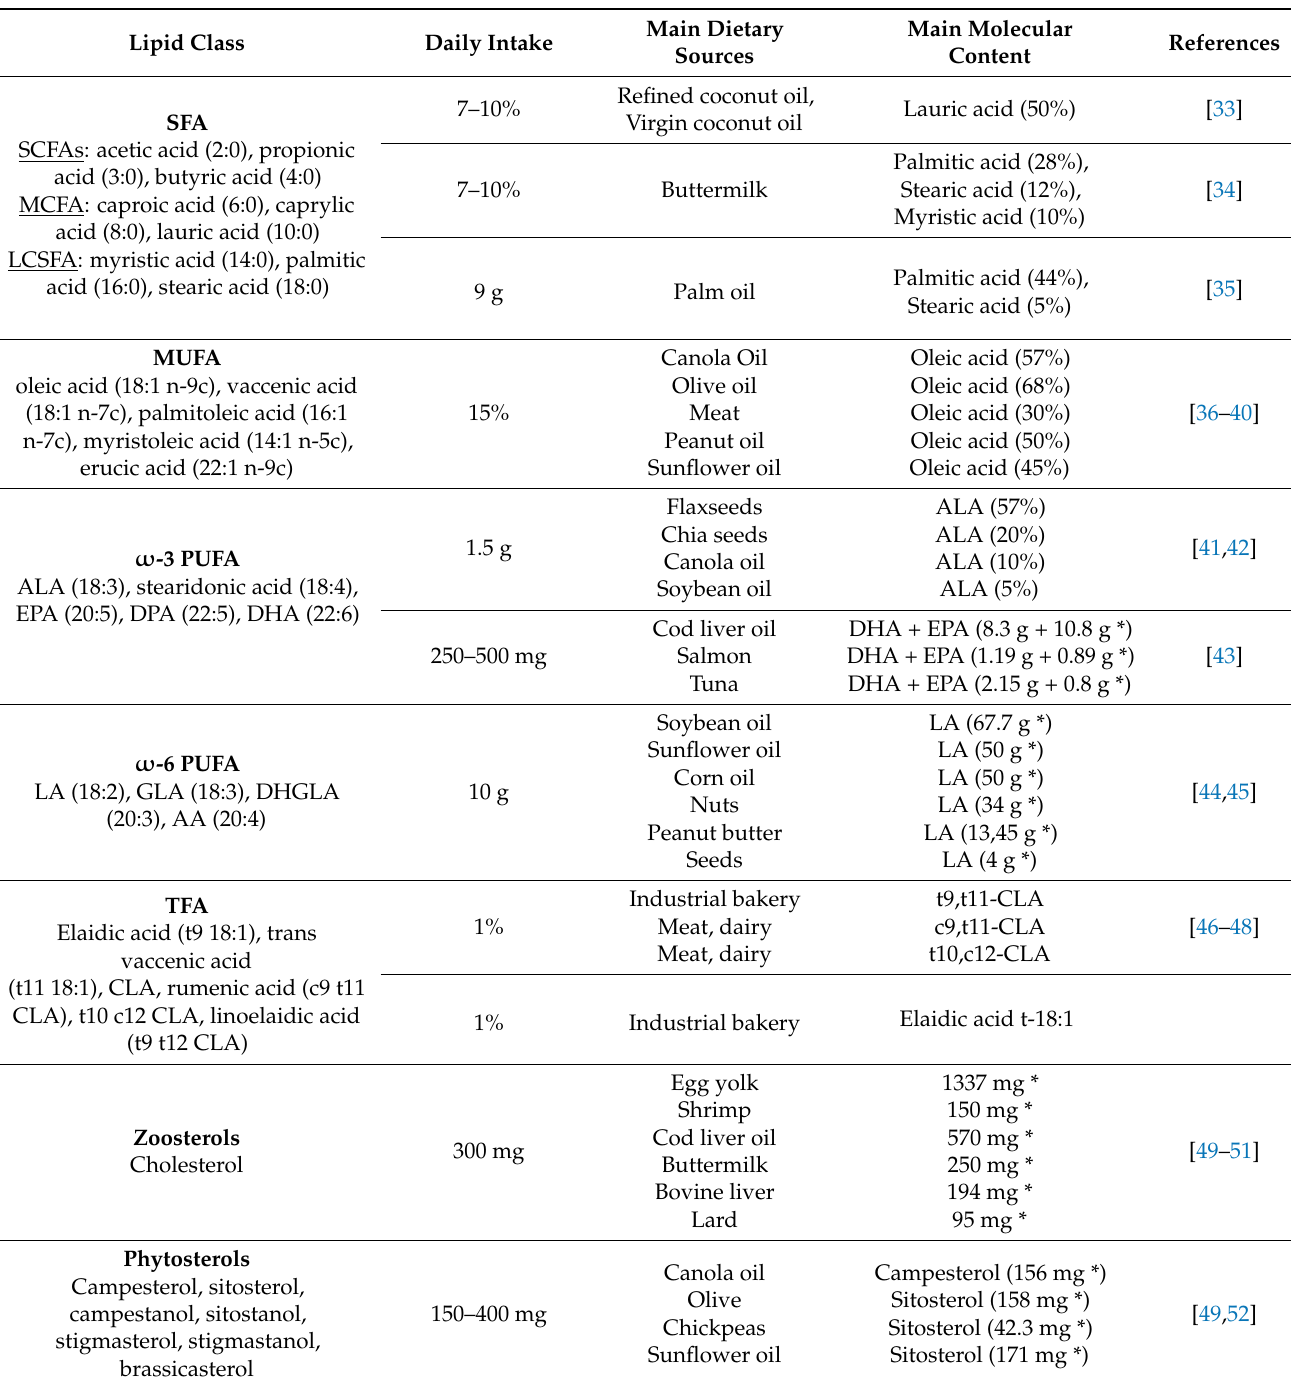
Table 1. Dietary lipid sources, average daily intake, and main dietary